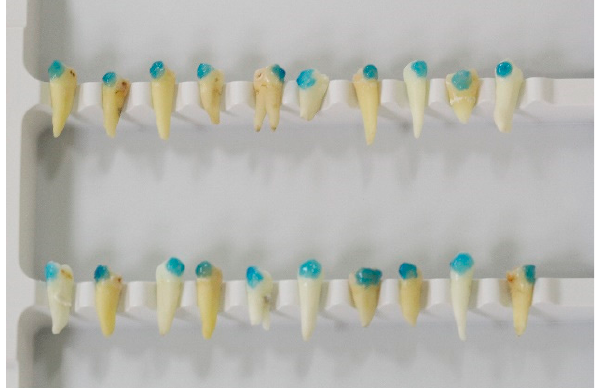
Figure 2. Etched premolars.